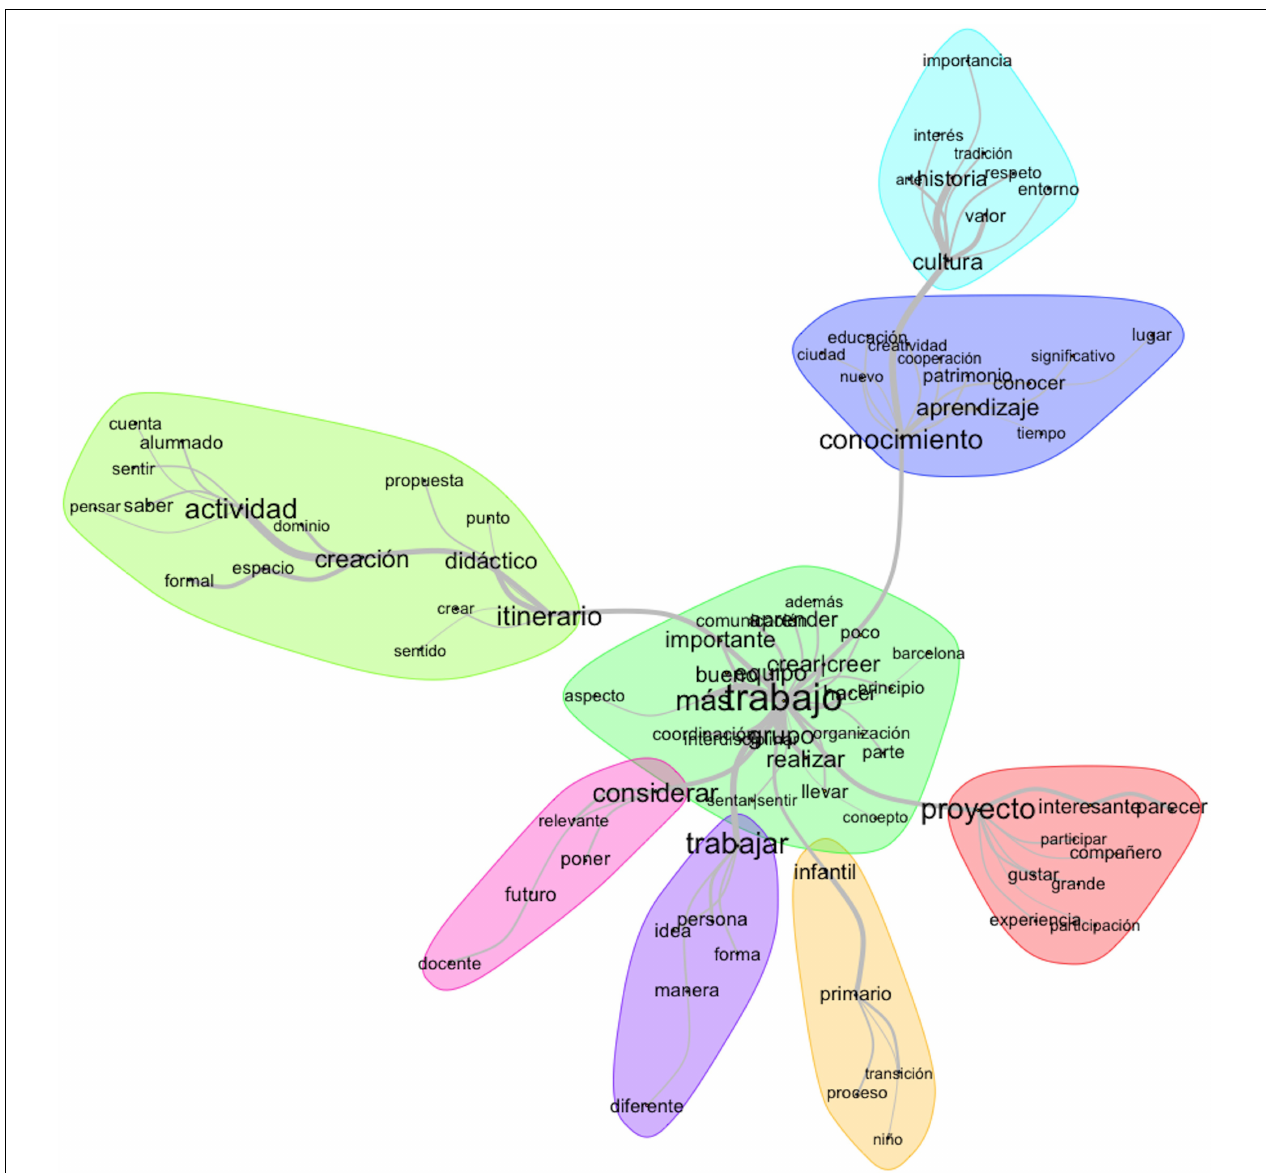
FIGURE 2 | Graphical representation of the discourses collected in the open questions of the final